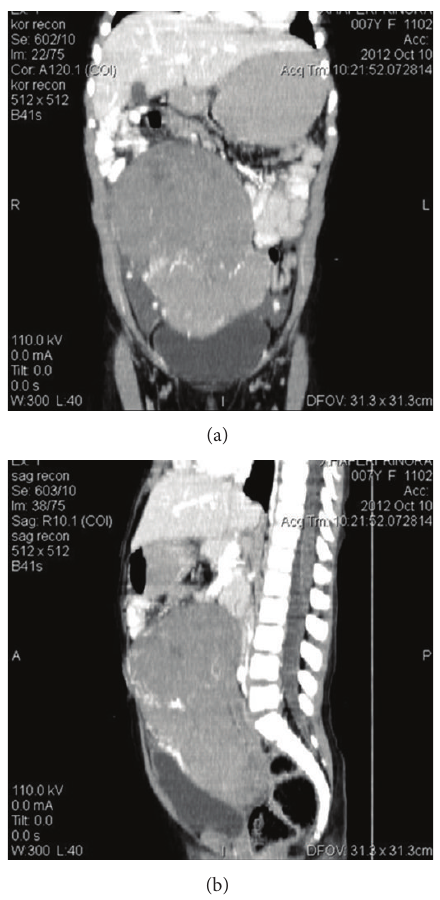
Figure2:Afteranadditionalexaminationwithintravenouscontrast medium the tumour mass showed a raised vascularization within the tumour.